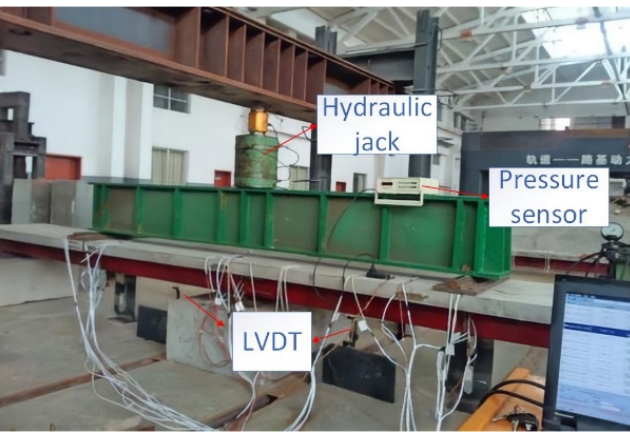
Figure 4. Schematic view of the fatigue tests.